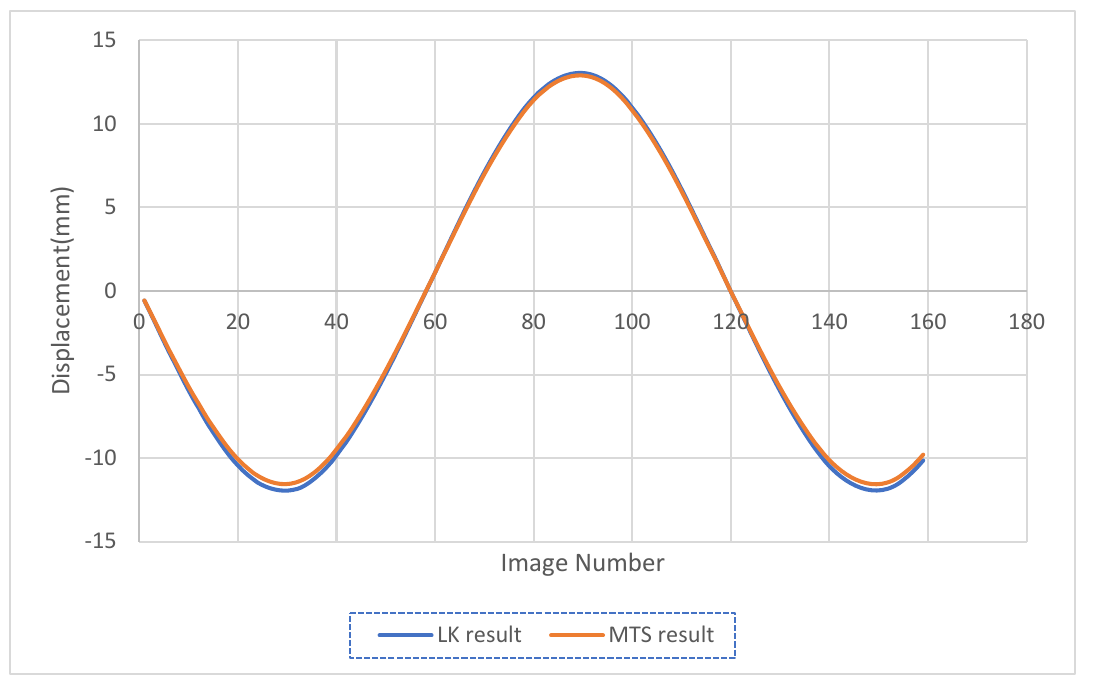
Figure 4. Displacement obtained using the direct LK optical flow, compared with the output of the MTS machine movement .